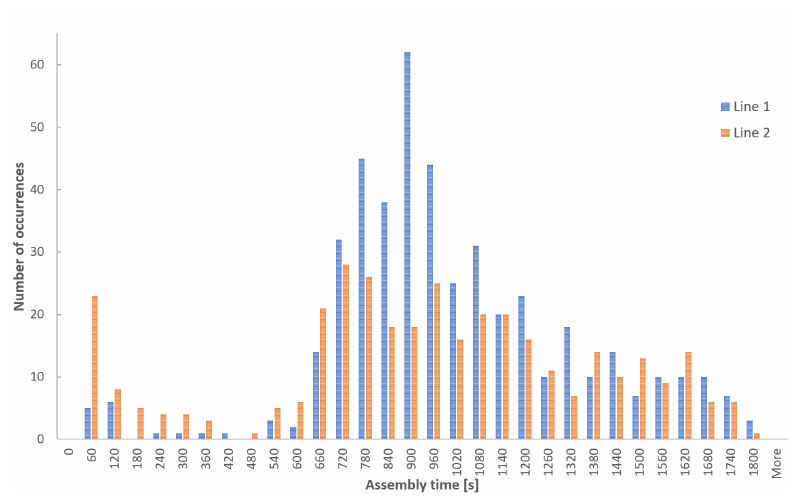
Figure 7. The histogram of measured processing times in two different conveyors (production lines). The histograms indicate that the distribution of the sensor-delivered processing times can be decomposed into normal distribution functions according to different